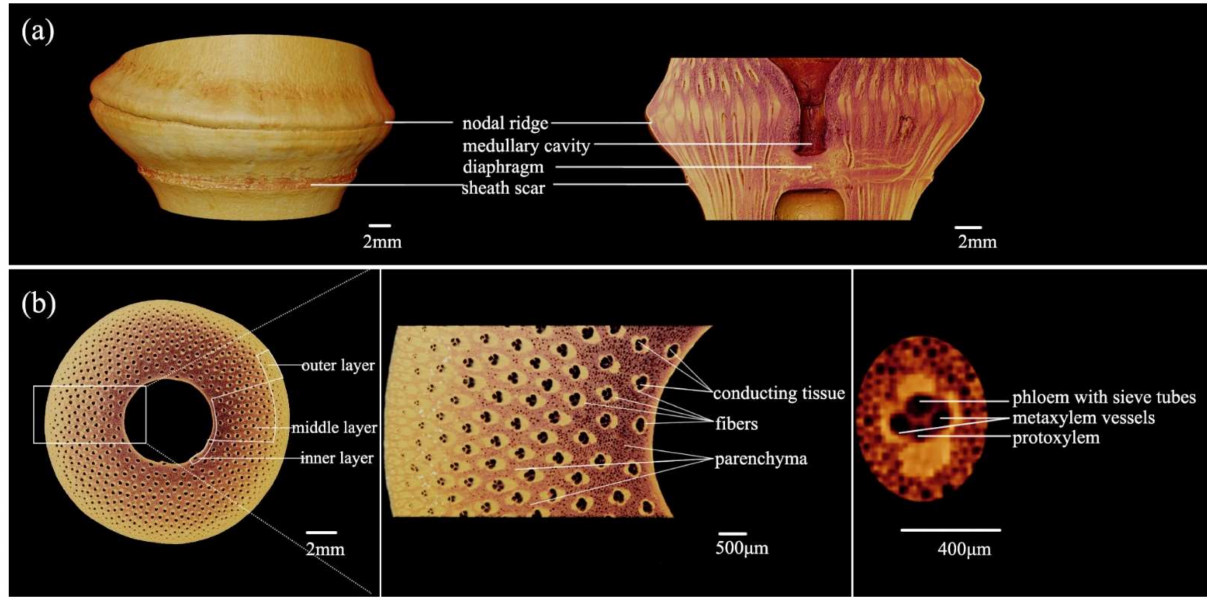
Figure 3. Morphology of the node in Q. tumidinoda . ( a ) Longitudinal section view. ( b ) Cross-section and